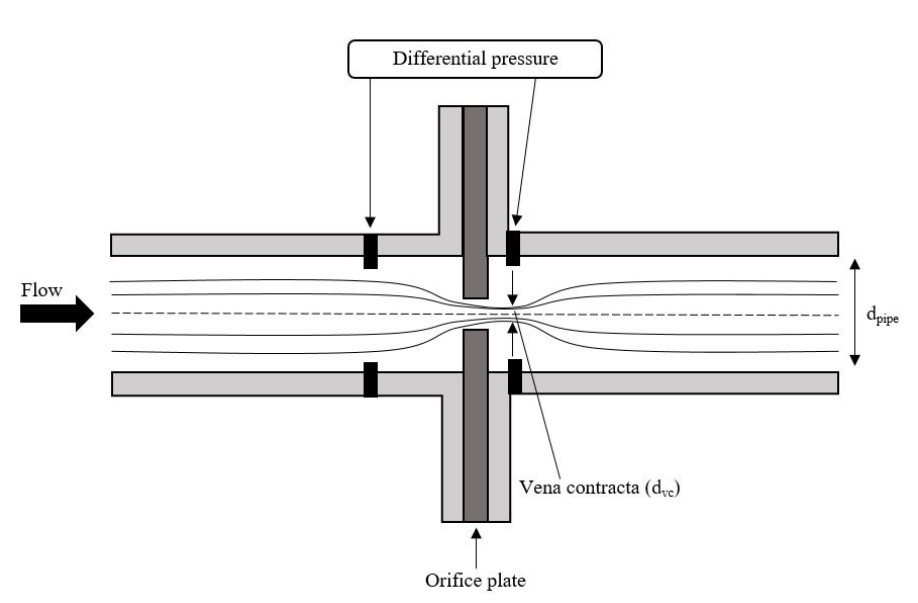
Figure 6. Principle of an orifice plate. Interruption of the flow inside a pipe due to an orifice plate. DP transmitters are measuring the pressure difference at a point before and after the orifice plate and the velocity of the fluid is hereby obtained by Bernoulli’s